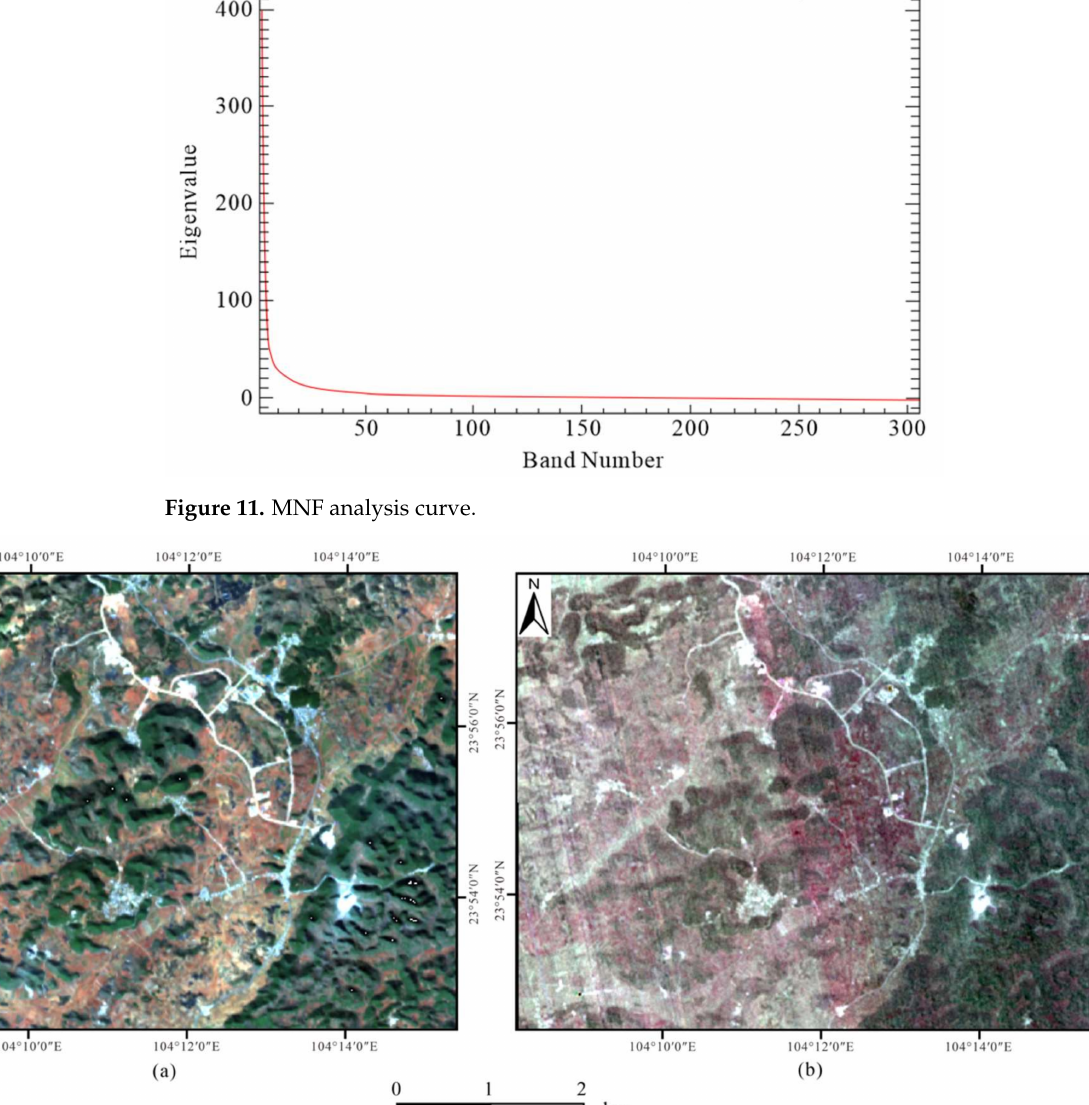
Figure 12. ( a ) Image before MNF transformation; ( b ) image after MNF